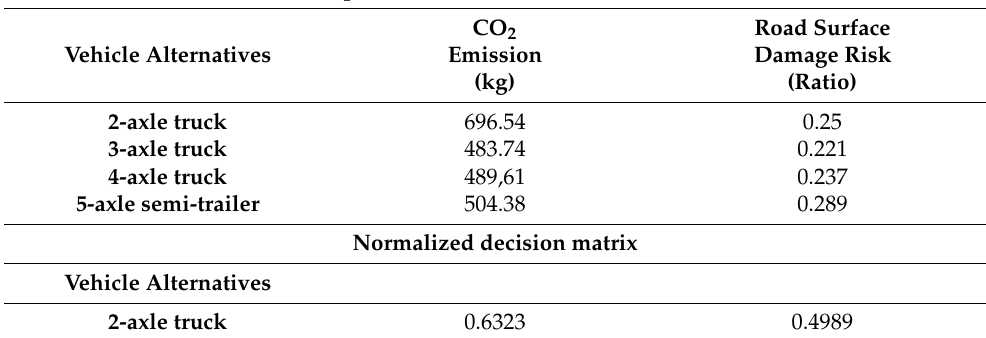
Table 21. Input matrix for TOPSIS method, normalized decision matrix, weighted normalized decision matrix and PIS, NIS. Input Matrix for TOPSIS Method.